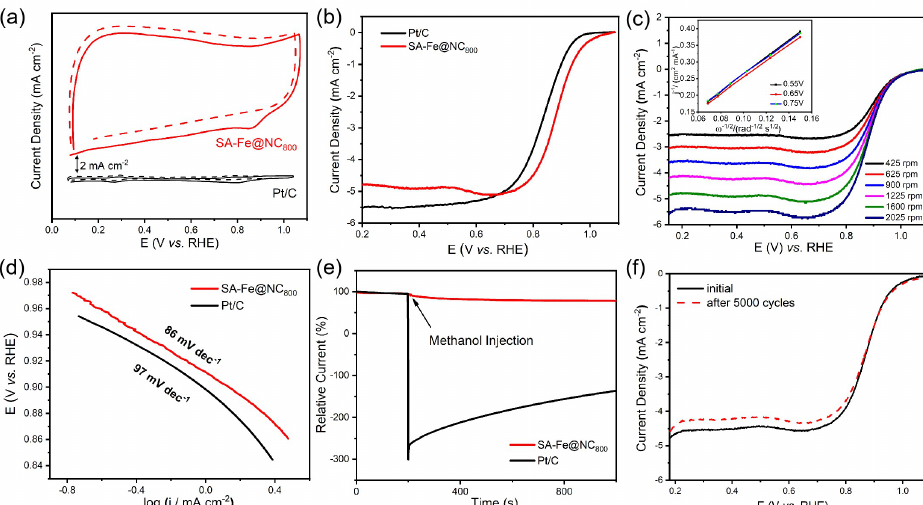
Figure 5. ( a ) CV curves of the SA-Fe@NC 800 and the commercial Pt/C catalysts in the O 2 -saturated (solid line) and N 2 -saturated (dashed line) 0.1 M KOH solutions at a sweep rate of 50 mV s − 1 . ( b ) LSV curves of the catalysts in the O 2 -saturated 0.1 M KOH electrolyte at 10 mV s − 1 with a rotation rate of 1600 rpm. ( c ) LSV curves of the SA-Fe@NC 800 in the O 2 -saturated 0.1 M KOH solution at 50 mV s − 1 with different rotation rates (inset shows the corresponding Koutechy–Levich plots). ( d ) Tafel plots of the SA-Fe@NC 800 in 0.1 M KOH. ( e ) Methanol crossover effect test of the SA-Fe@NC 800 and Pt/C at 0.8 V. 3 mL of methanol was injected into the O 2 -saturated 0.1 M KOH solution (90 mL) at 200 s. ( f ) LSV curves of SA-Fe@NC 800 before and after 5000 CV cycles between 0.6 and 1.0